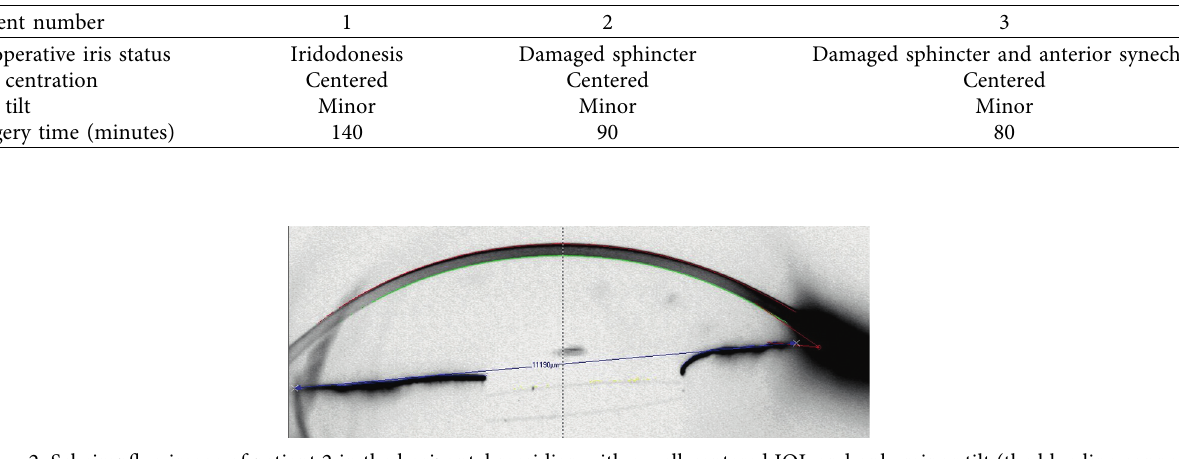
Table 2: Details of preoperative iris status and postoperative IOL centration and tilt in the patient population.